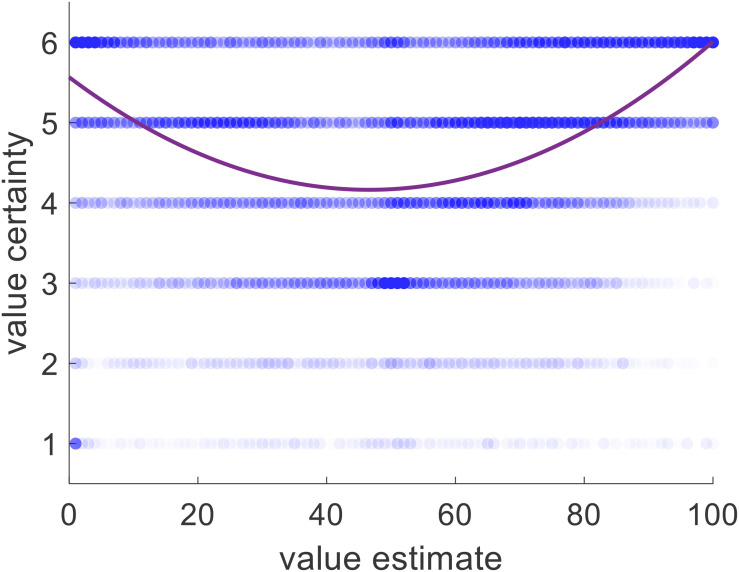
Value certainty is related to value estimate, with both a linear effect and a quadratic one. Blue dots represent one item for one participant for one rating session. Purple curve represents the best linear + quadratic fit across all trials and all participants.